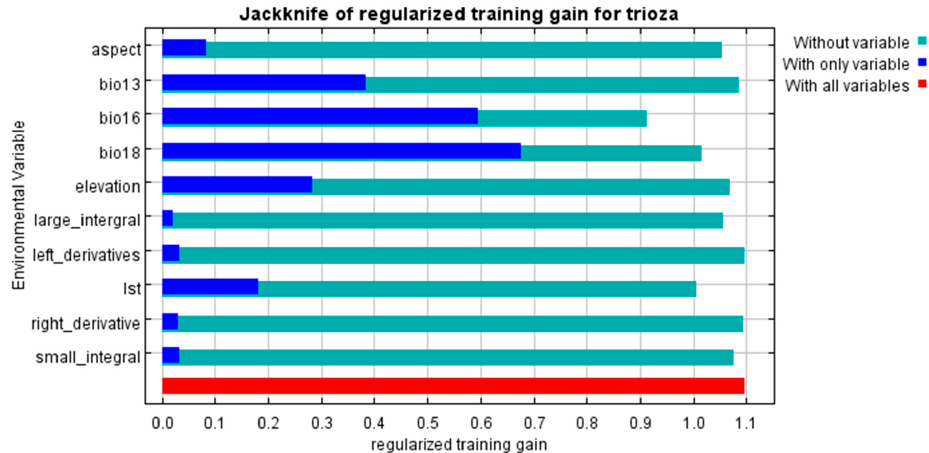
Figure 5. Jackknife variable importance test of regulated gains for the BCL-RS model. The dark blue shades show the regularized training gain for the specific variable, light blue illustrates gains without the variable, while red shows the regularized training gain with all the variables combined.